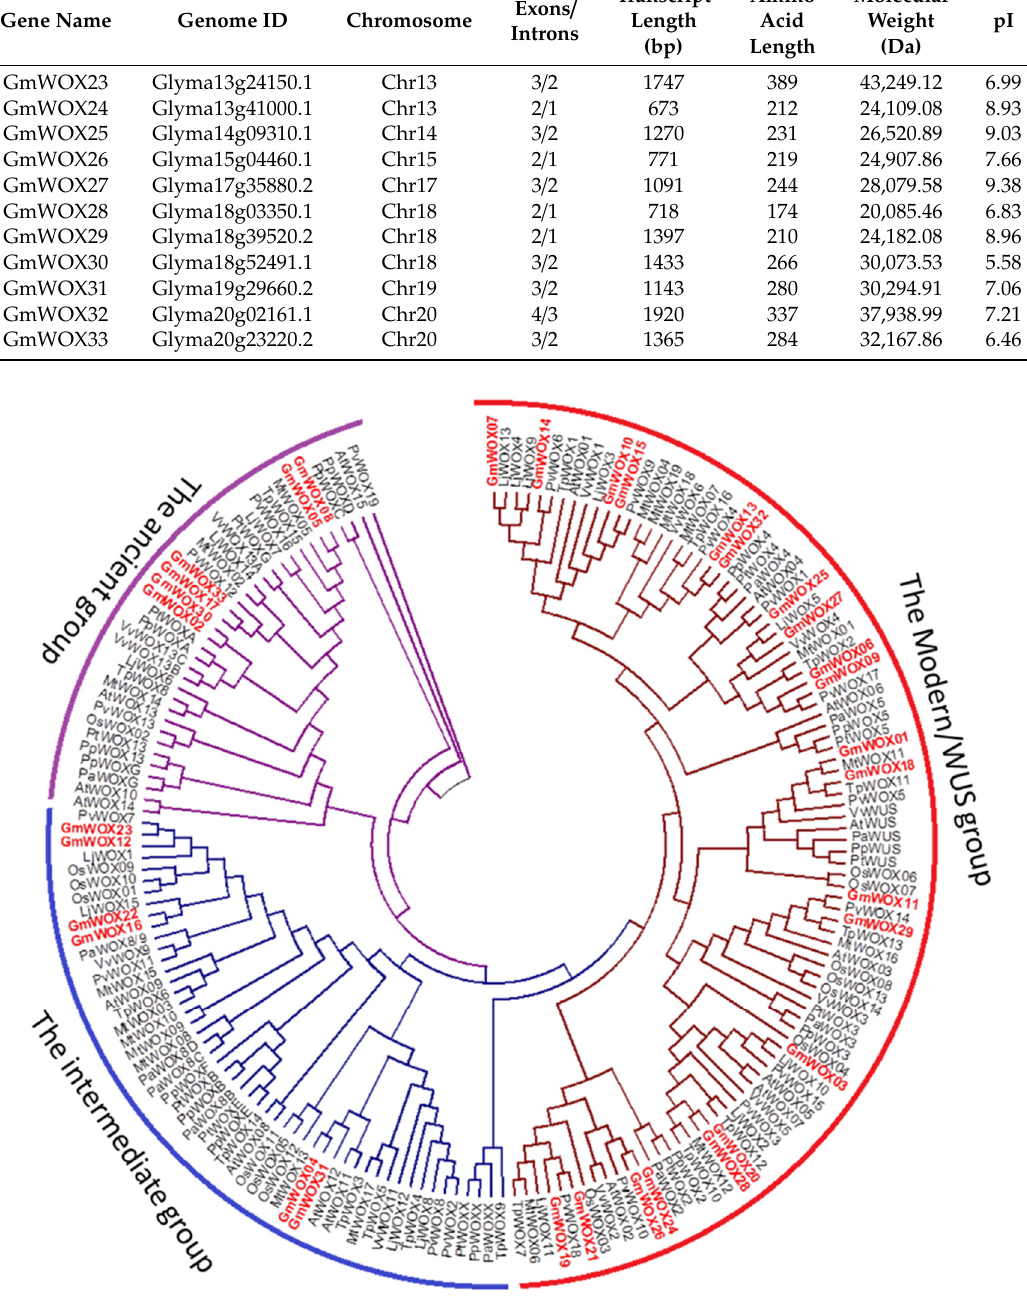
Figure 1. Phylogenetic relationships of the WUSCHEL-related homebox’s (WOXs). Phylogenetic relationships of the WOXs from soybean (Gm), Medicago truncatula (Mt), Arabidopsis (At), Lotus japonicus (Lj), common bean (Pv), Trifolium pretense (Tp), Picea abies (Pa), Pinus pinaster (Pp), Vitis vinifera (Vv) and rice (Os). The phylogenetic tree was constructed using Mega 6. The 181 WOXs from 10 plant species can be divided into 3 groups; branches are colored differently.